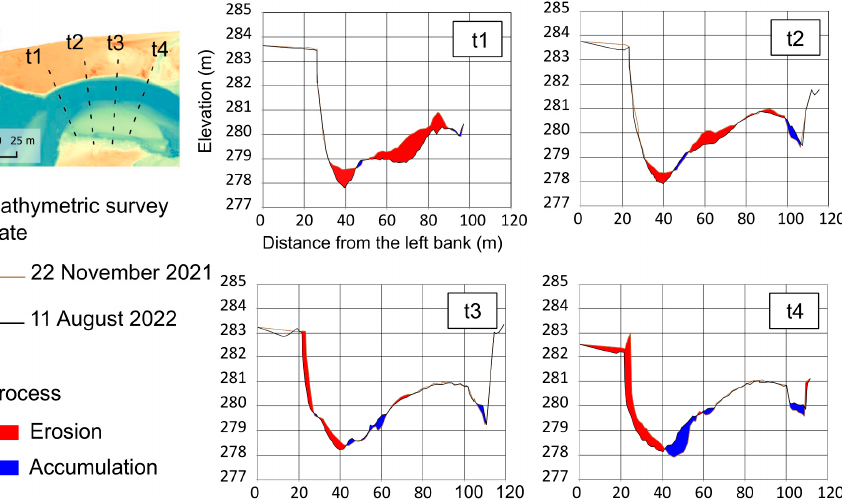
Figure 8. Comparison of topobathymetric surveys between 22 November 2021 and 11 August 2022 along four transects (t) at Site 2.